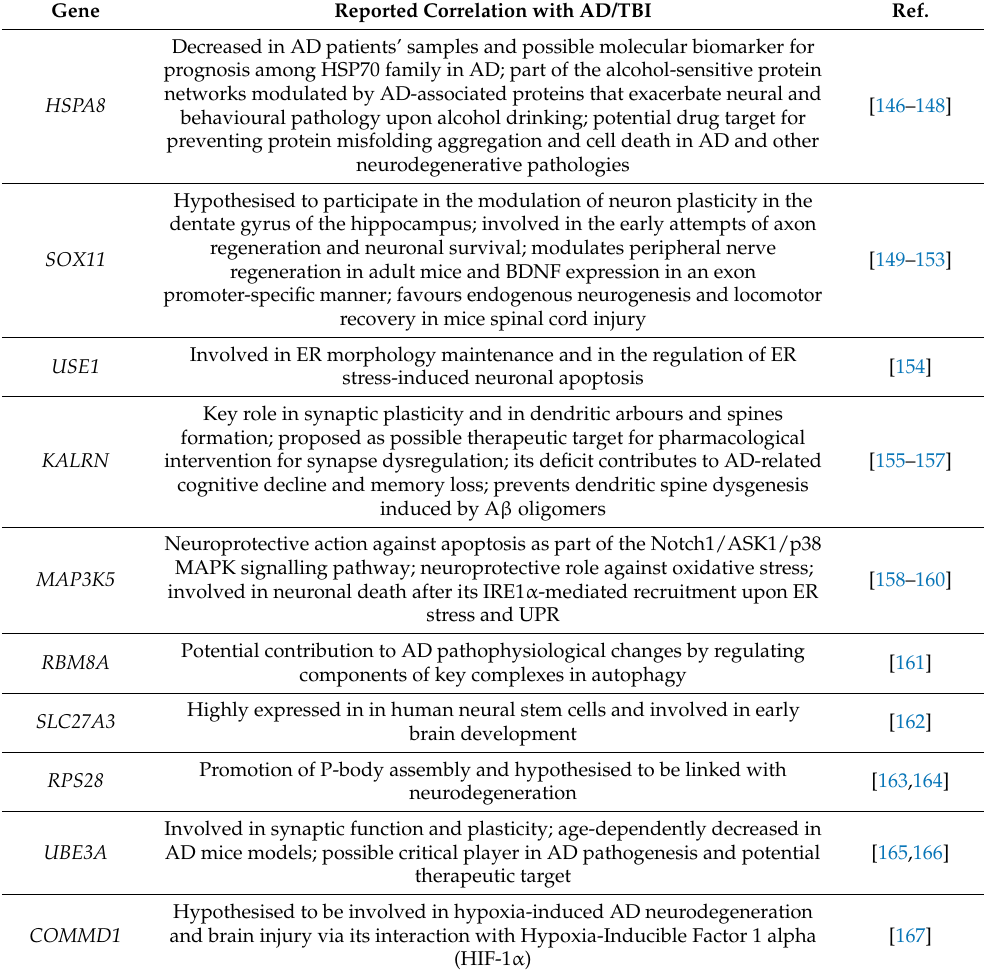
Table 3. Reported involvement in AD and TBI of sAPP α -correlated up- and down-regulated genes here not